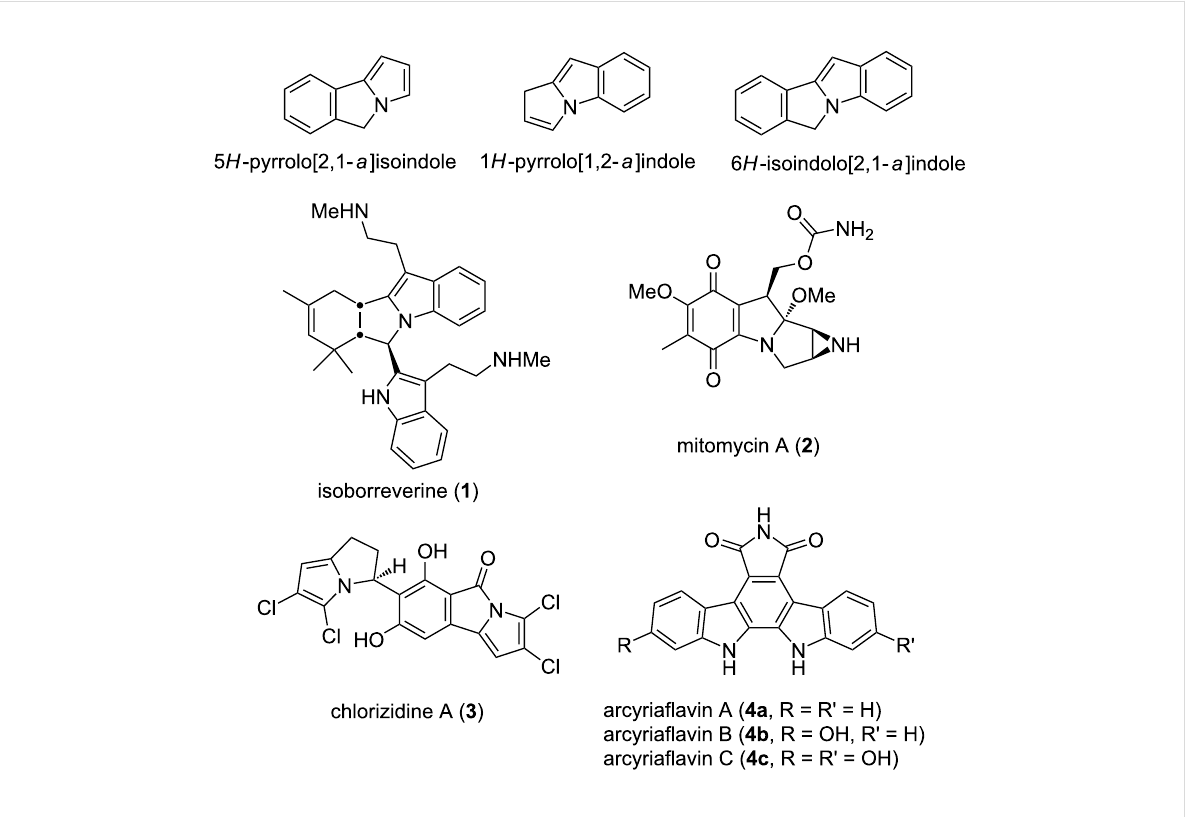
Figure 1: Fused aza-hetero polycyclic frames and natural pyrrolizine- and isoindole-containing